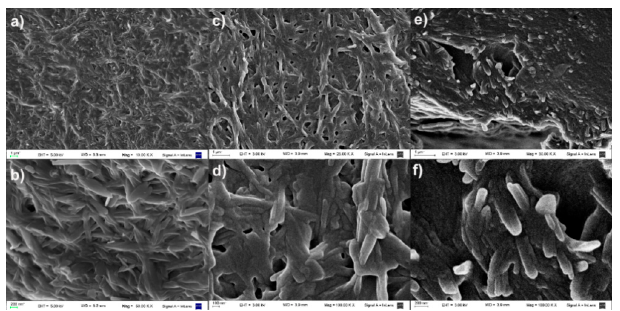
2 ( c , Mag = 25.00 KX), ( d , Mag = 100.00 KX), and 3 ( e , Mag = 30.00 KX), ( f , Mag = 100.00).